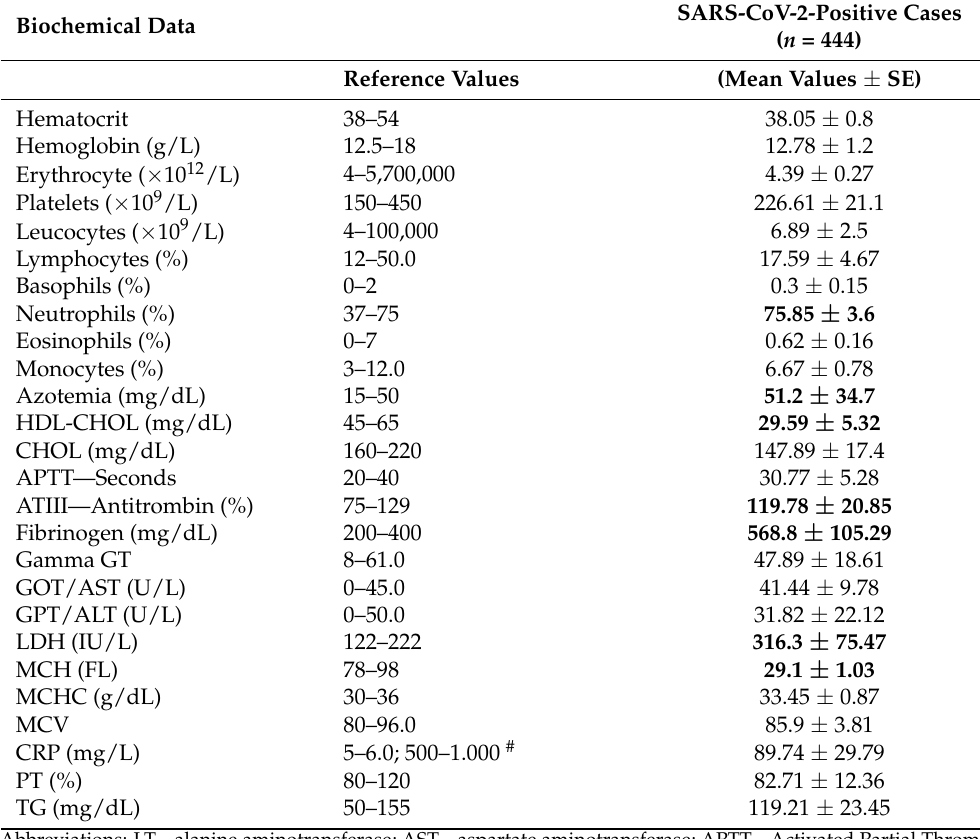
Table 5. Laboratory features of the SARS-CoV-2-positive patients of the Infective Disease